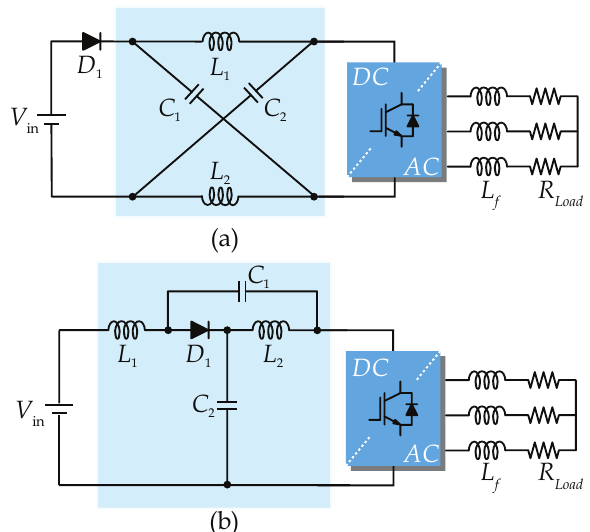
Figure 1. Circuit schematics of impedance-source-fed three-phase inverters: ( a ) Z-source inverter [1], and ( b ) quasi-Z-source inverter [3].